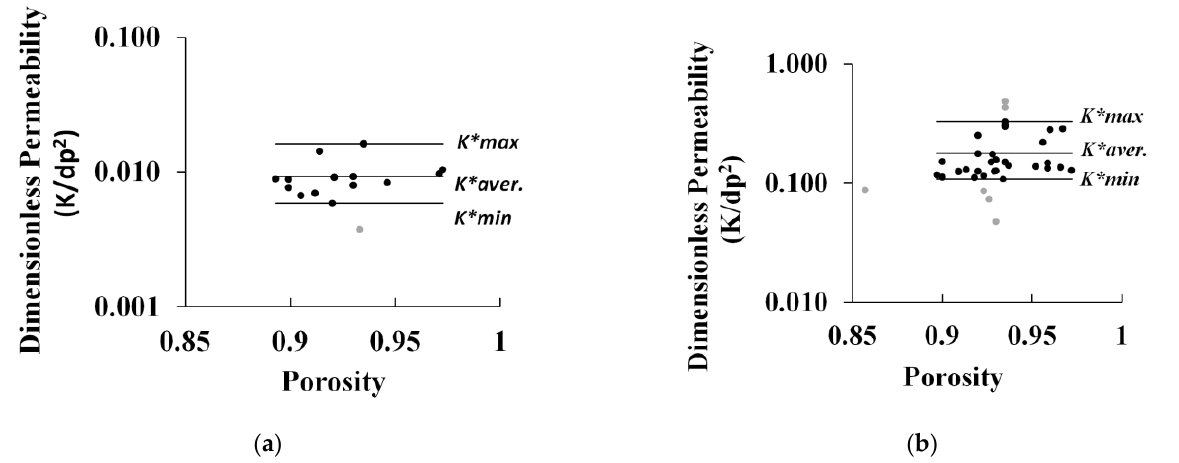
Figure 3. The change of dimensionless permeability with respect to porosity for aluminum foams, ( a ) 5 PPI, ( b ) 40 PPI, (Discarded values are shown by grey color). Table 3. The suggested dimensionless permeability and inertia coefficient ranges for 5 and 40 PPI aluminum